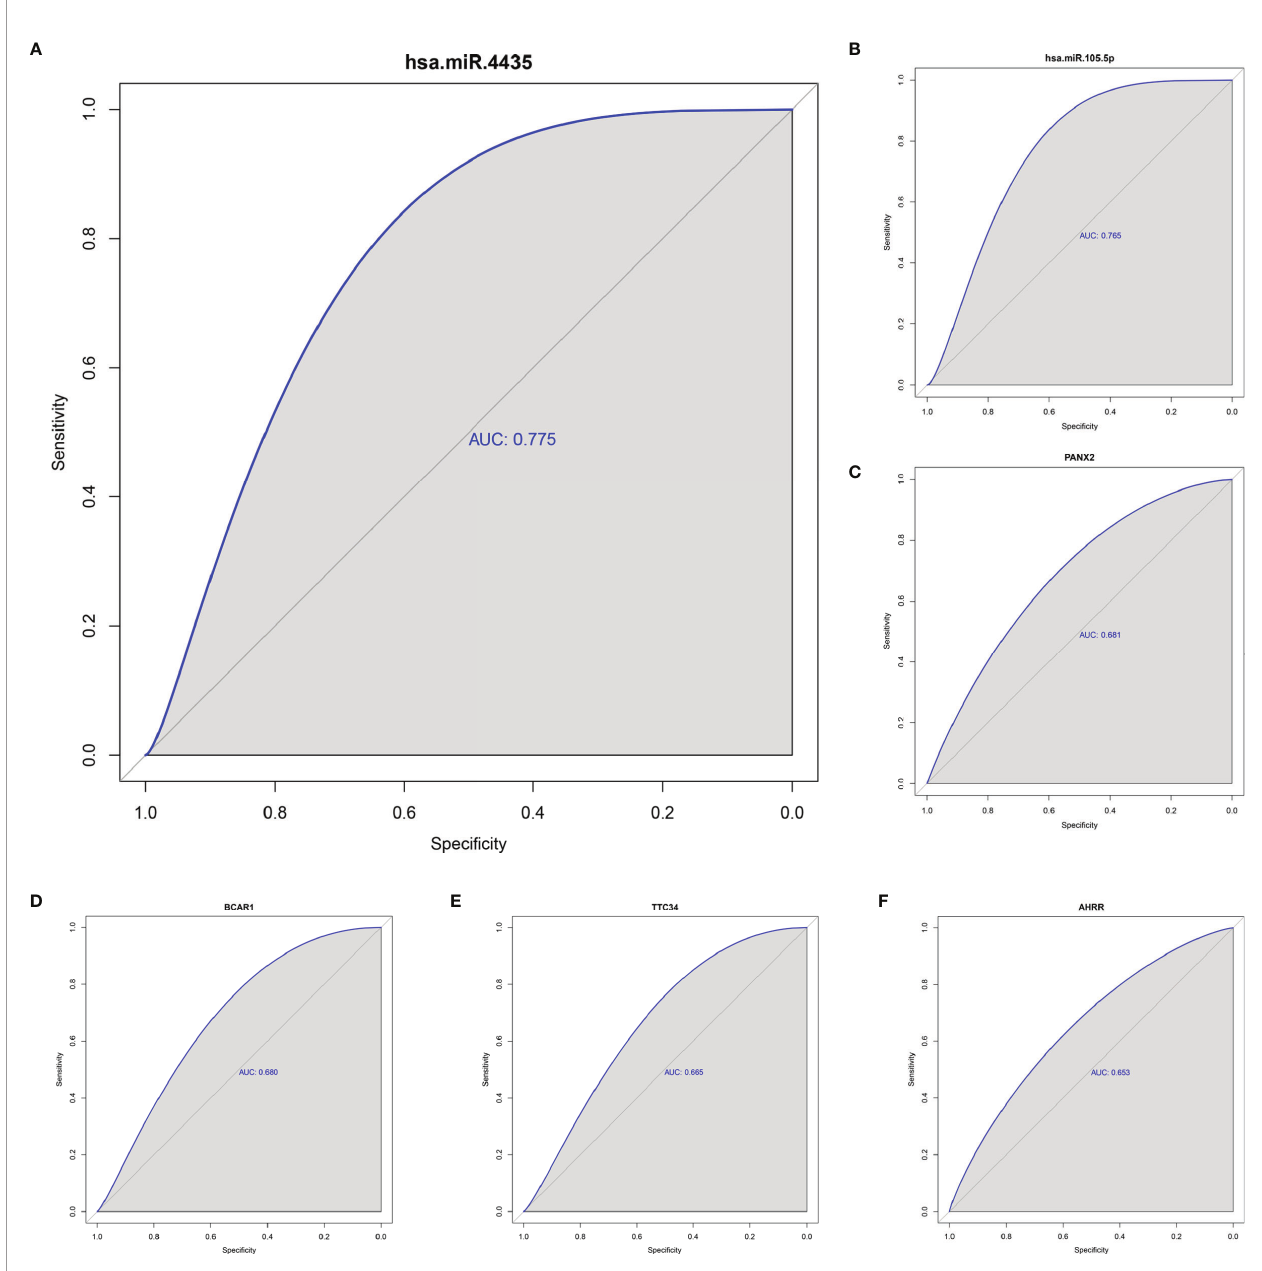
FIGURE 6 | ROC analysis of 6 prognostic RNAs (only showing the AUC > 0.65). hsa-miR-4435 (A) , hsa-miR-105-5p (6), PANX2 (C) , BCAR1 (D) , TTC34 (E) , AHRR (F) . ROC, receiver operating characteristic